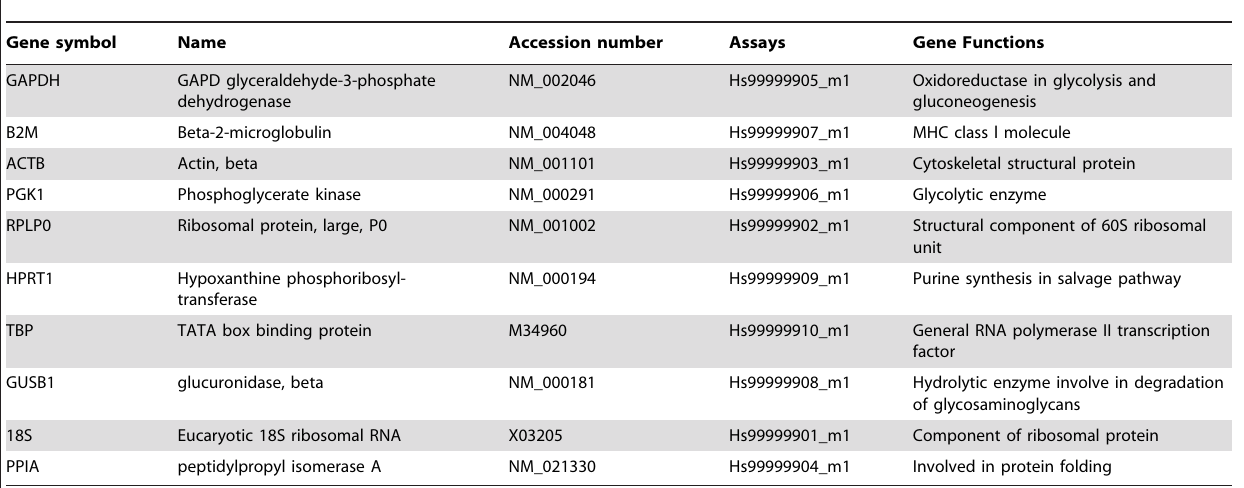
Table 1. Endogenous control genes analysed with geNorm software in this